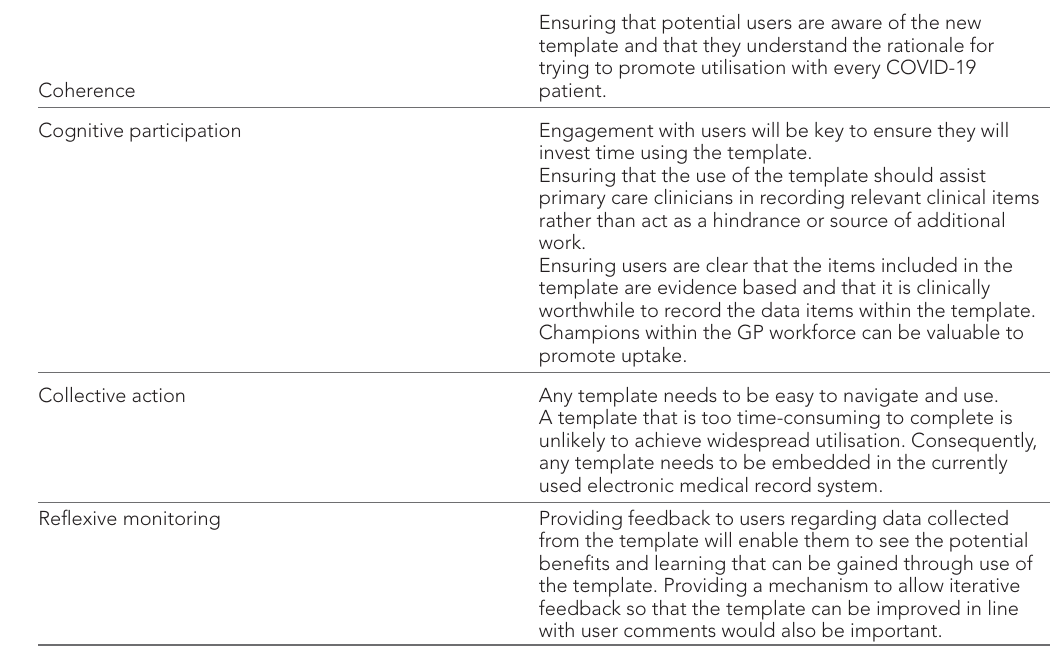
Table 3 Key Normalisation Process Theory- informed implementation issues to consider when intro- ducing a new COVID-19